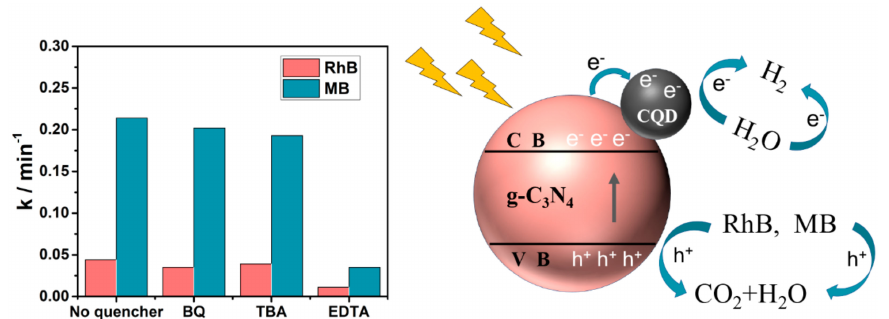
Figure 10. Proposed mechanism for methylene blue (MB) and RhB degradation by CCN under light